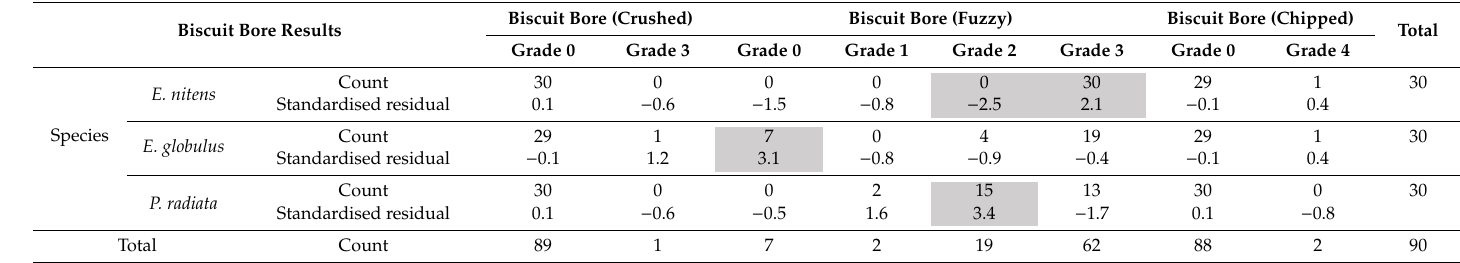
Table 7. Grading results according to biscuit